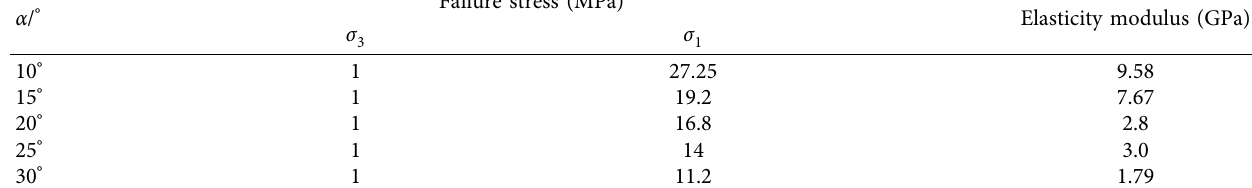
Table 1: Triaxial compression test results of mudstone specimens with different joint plane angles.